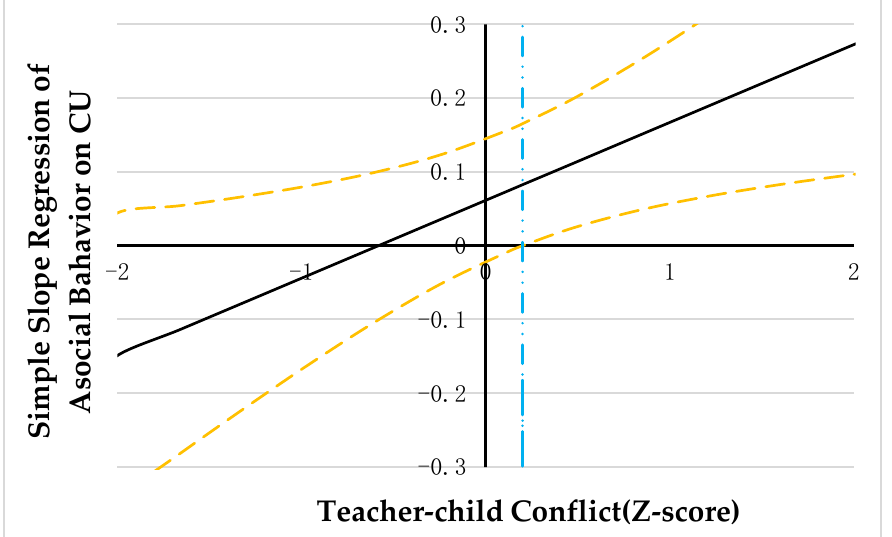
Figure 4. Johnson-Neyman regions of significance and confidence bands for mother-rated CU traits along teacher-child conflict in relation to asocial behavior. Note. Solid diagonal line represents the regression coefficient for CU along with teacher-child conflict. Dashed diagonal yellow lines are confidence bands — upper and lower bounds of 95% confidence interval for CU coefficient along teacher-child conflict. The dashed vertical blue line indicates the point along teacher-child conflict at which the CU regression coefficient transitions from nonsignificance (left of dashed vertical line) to statistical significance (right of dashed vertical line). The value of the dashed vertical line is 0.20.